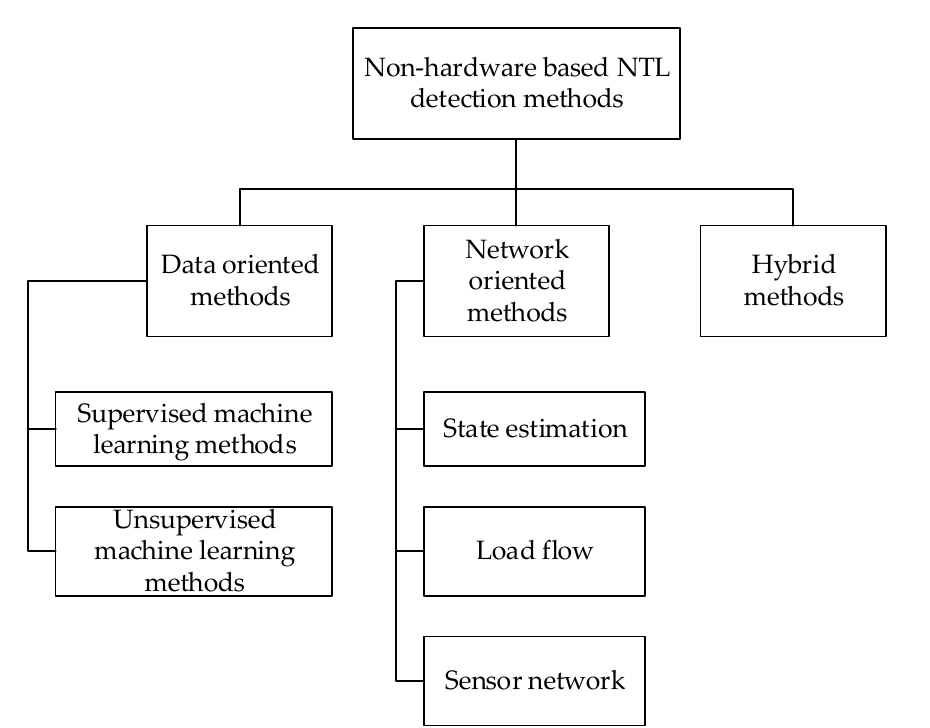
Figure 1. Non-hardware-based Non-Technical Losses detection methods.